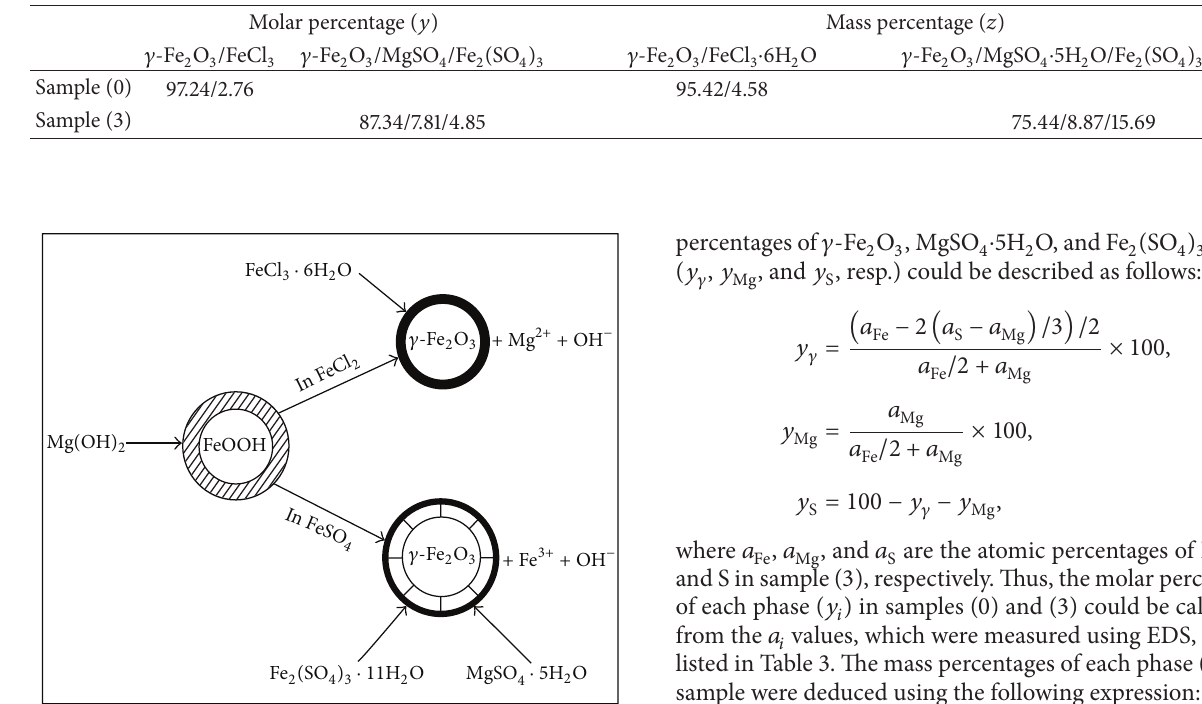
Table 3: Molar and mass percentages of phases in samples ( 0 ) and ( 3 ).